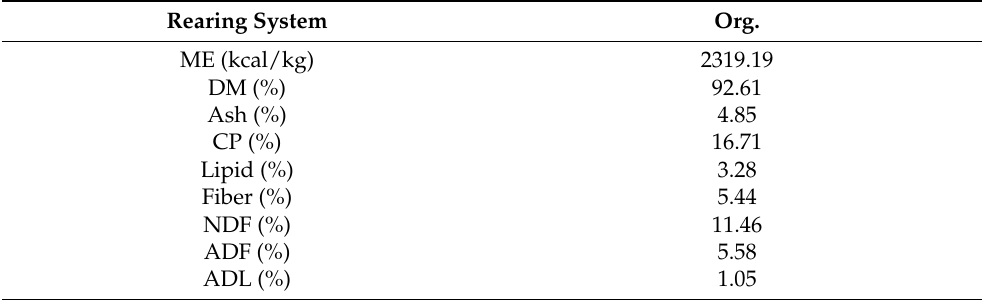
Table 1. Chemical composition of feed supplied to chickens reared under organic (Org.) systems. Rearing System